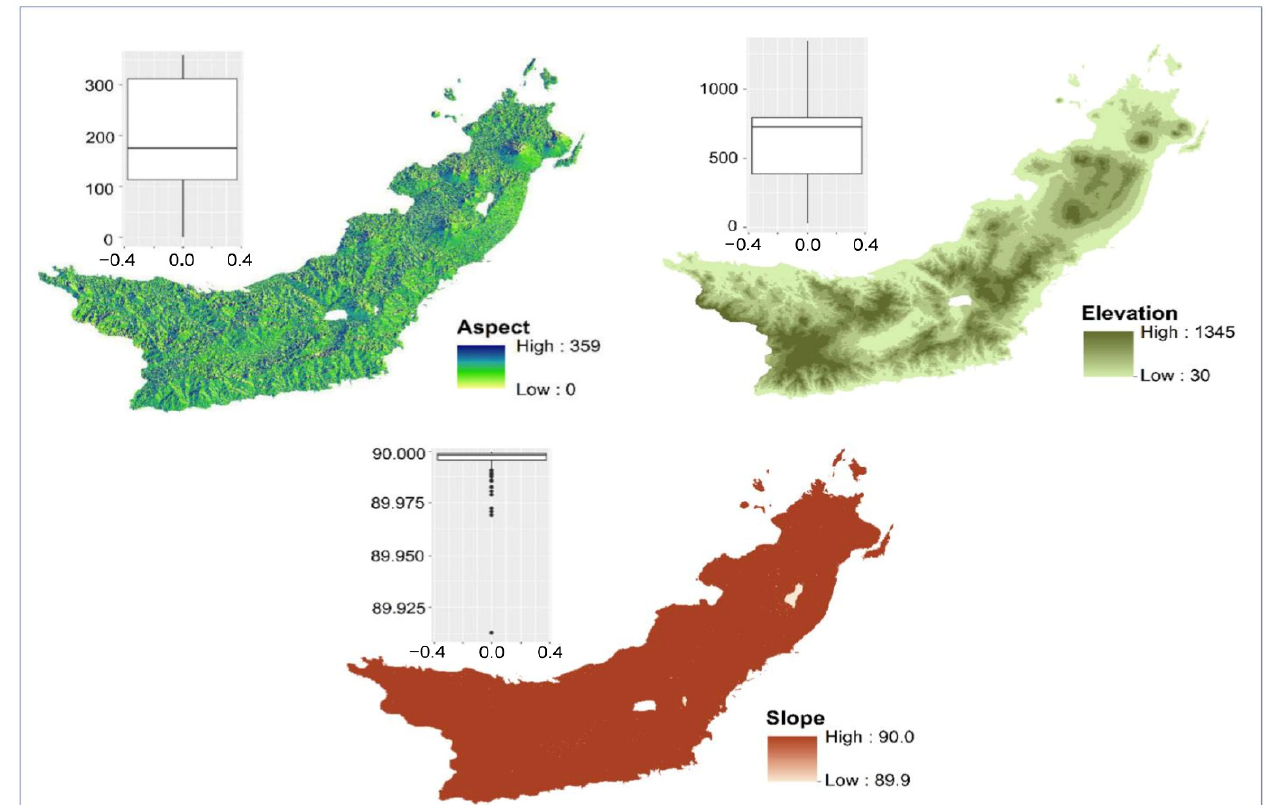
Figure 5. Topographical indicator images for Magnolia spp. in North Sulawesi.